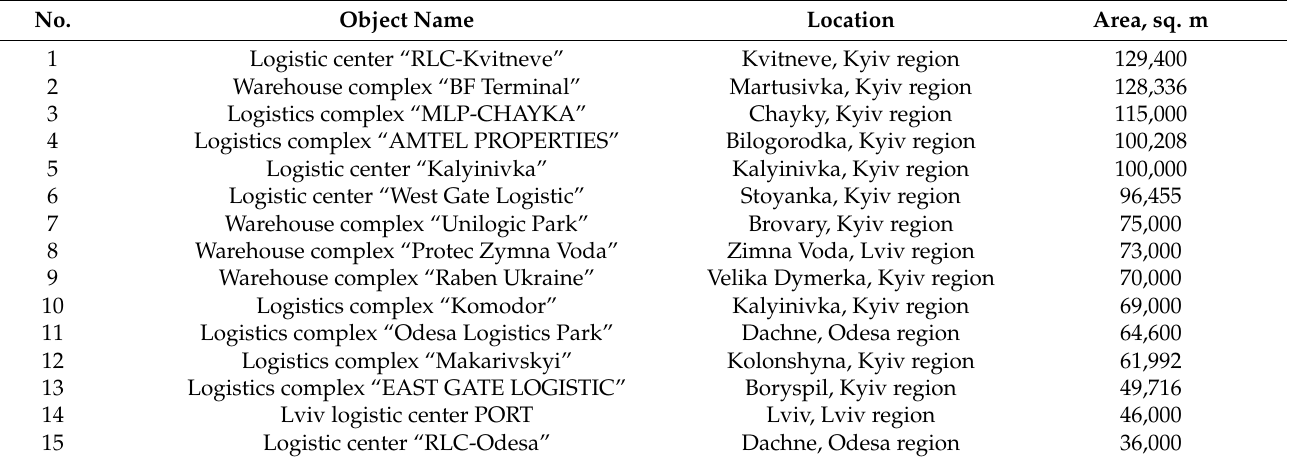
Table 1. The largest warehouses in Ukraine,